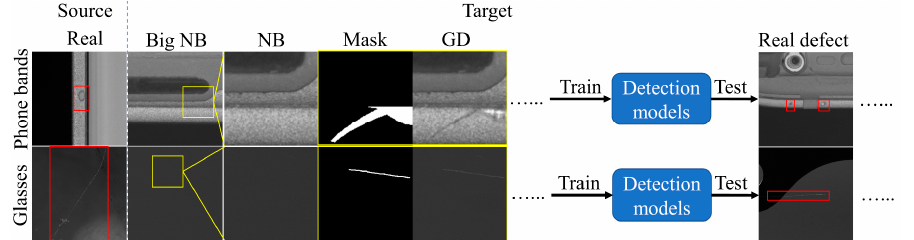
Figure 11. The first row shows the two types of Phone bands , and the second is the two types of glass . Red boxes indicate real defects. Source is the defect image used for training MDGAN. Target means the images to be transferred. NB is the normal background cut from Big NB . Mask is the input binary mask. GD is the generated target defect image. Real defect is defect image of the target datasets to be tested.